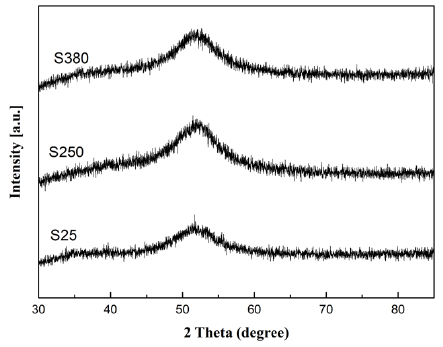
Figure 2. XRD patterns for amorphous alloy ribbons in different structural states: S25, S250 , and S380 .